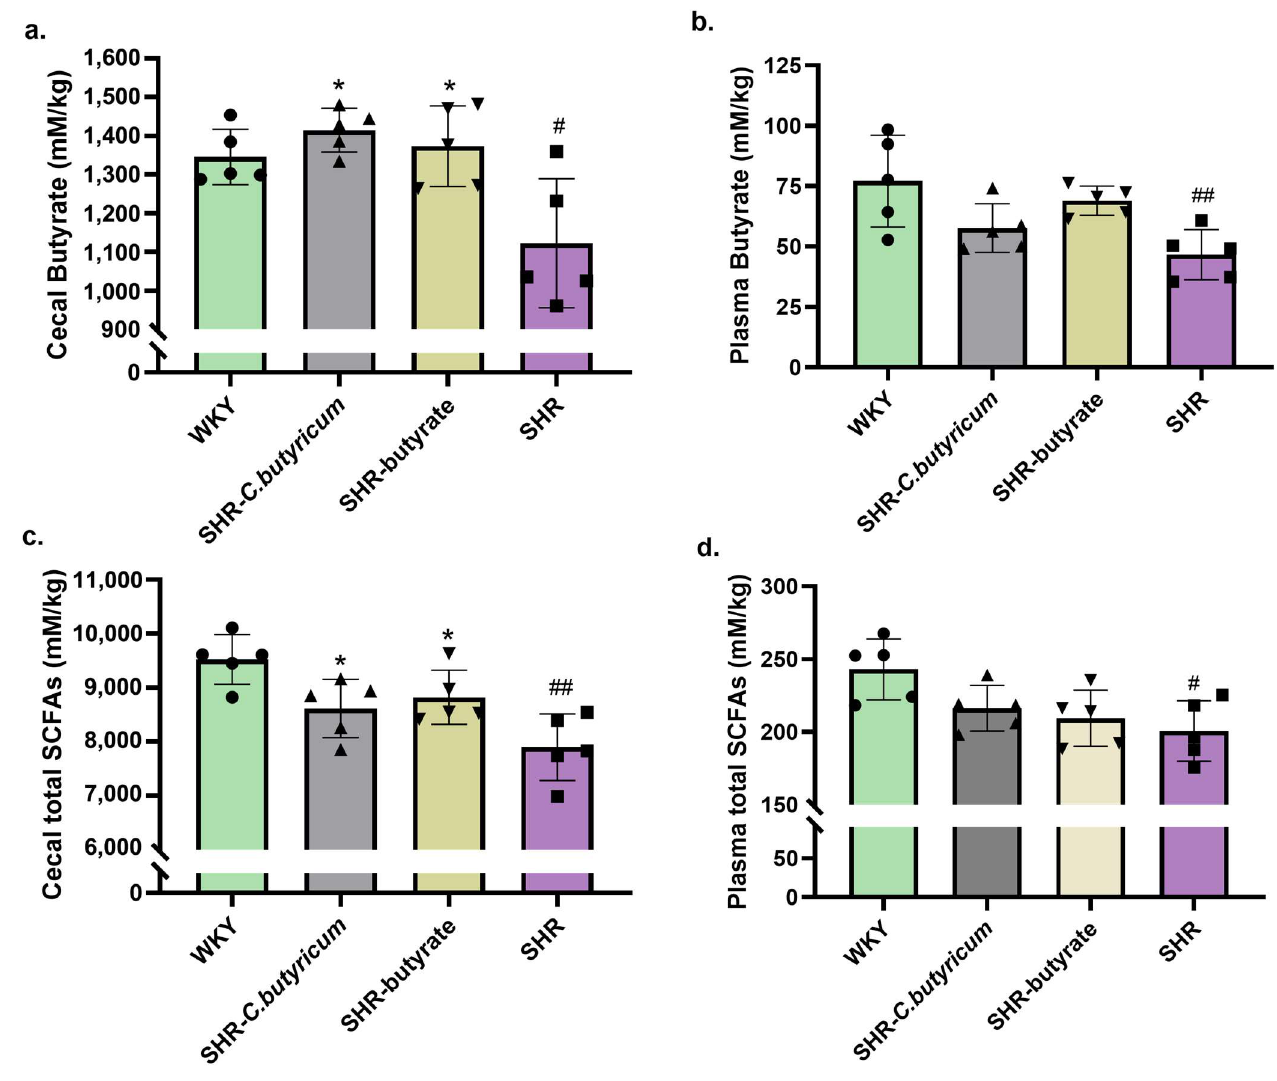
Figure 5. SHR reduced cecal and plasma SCFAs concentration, which was prevented by C. butyricum and butyrate. ( a , c ) Cecal and plasma total SCFAs concentration were significantly increased by C. butyricum and butyrate (n = 5 per group). ( b , d ) The reduction in SCFAs concentration in SHR cecal and plasma was prevented by C. butyricum and butyrate (n = 5 per group). Data are shown as the mean ± S.E.M., * p < 0.05 for SHR vs. SHR- C. butyricum or SHR-butyrate. # p < 0.05, ## p < 0.01 for SHR vs.